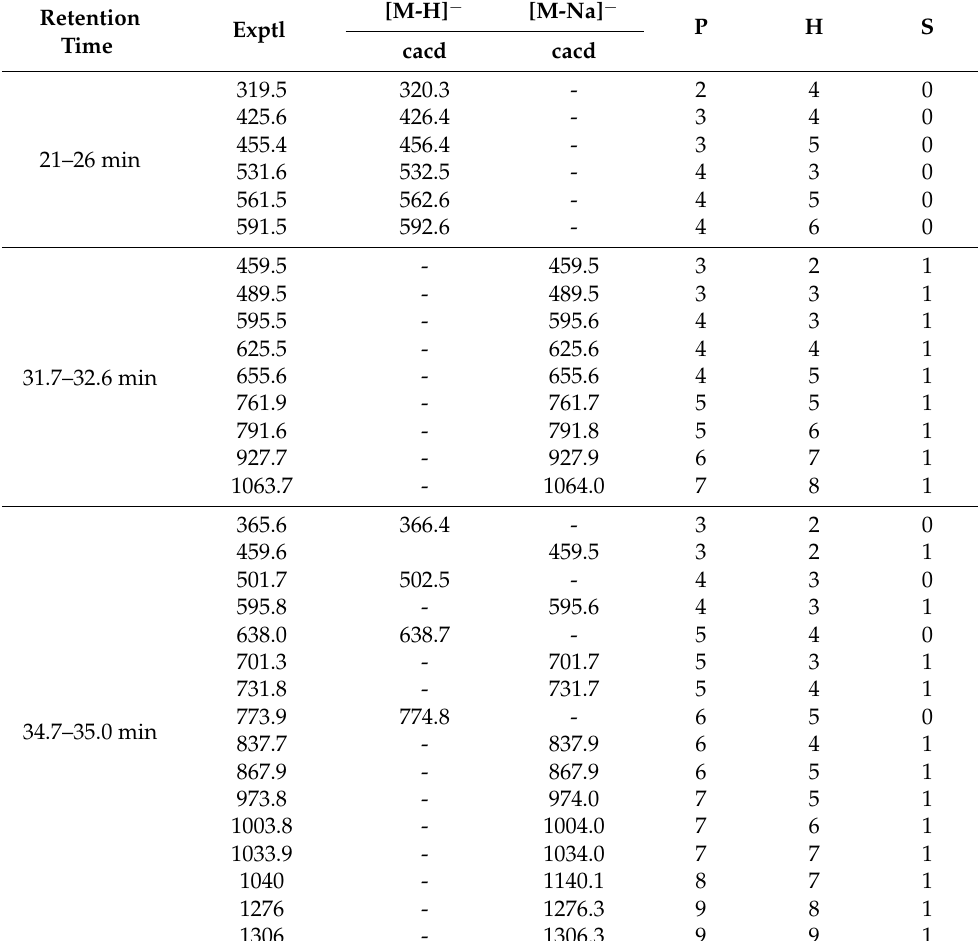
Figure 4. Total ion current chromatogram of SPF resin product (F/P was 2.0, S/P was 0.2). Table 1. Mass spectra of SPF resin in different retention times.